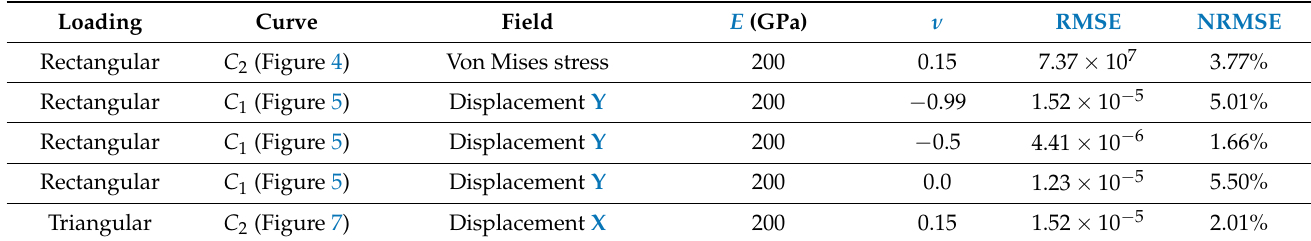
Table 1. RMSE and NRMSE of the displacement and Von Mises stress obtained for different study